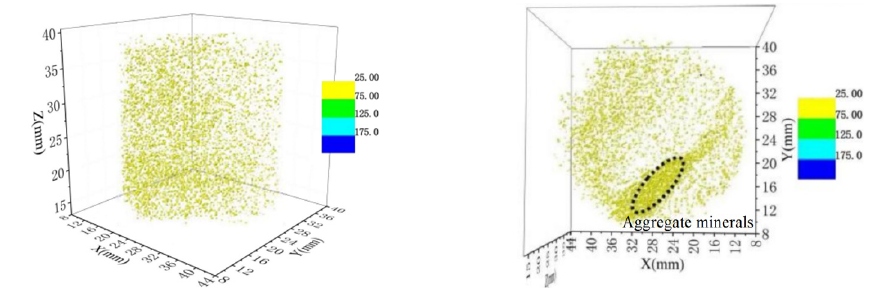
Figure 10. Spatial distribution of small size mineral particles.